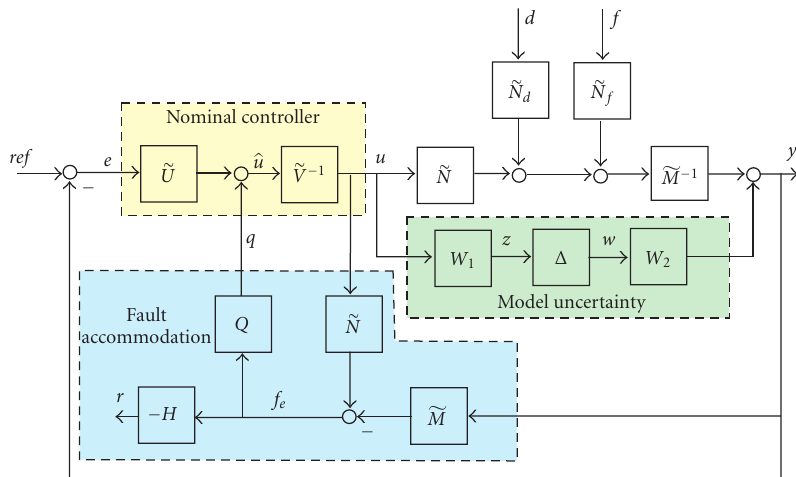
Figure 6: GIMC with additive perturbations, faults, and model